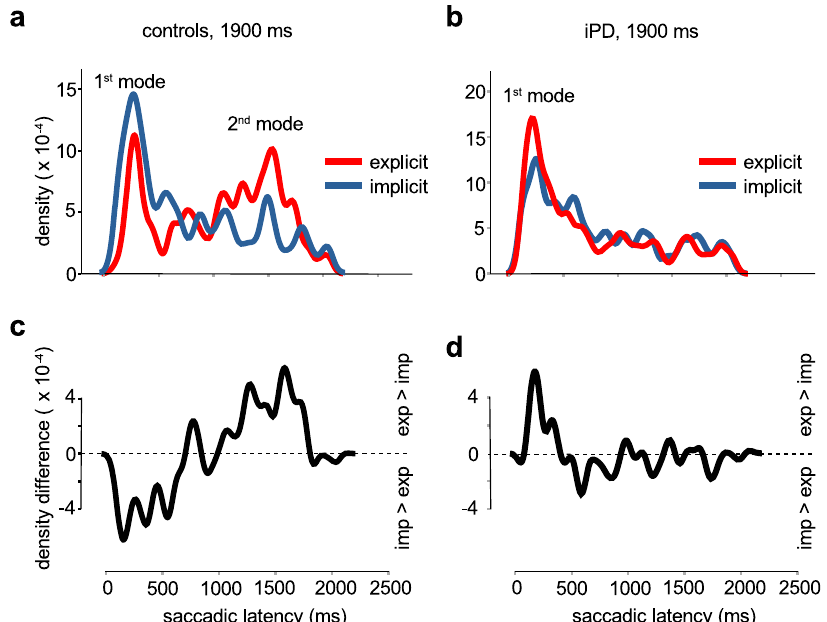
Fig. 6 Comparison of probability densities. Upper part: probability densities of saccadic latencies in the explicit (red curve) and implicit (blue curve) conditions for the 1900 ms FP duration in controls ( a ) and iPD patients ( b ). Densities were obtained by convolving latency distributions with a Gaussian kernel of fi xed width (40 ms). Lower part: difference of explicit and implicit latency densities for controls ( c ) and iPD patients ( d ).